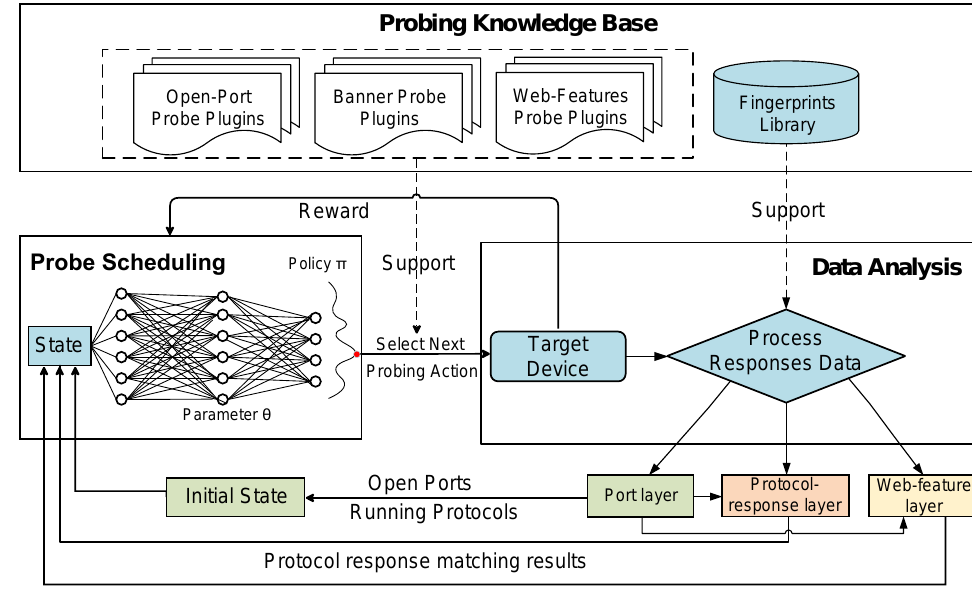
Figure 3. Overview of our